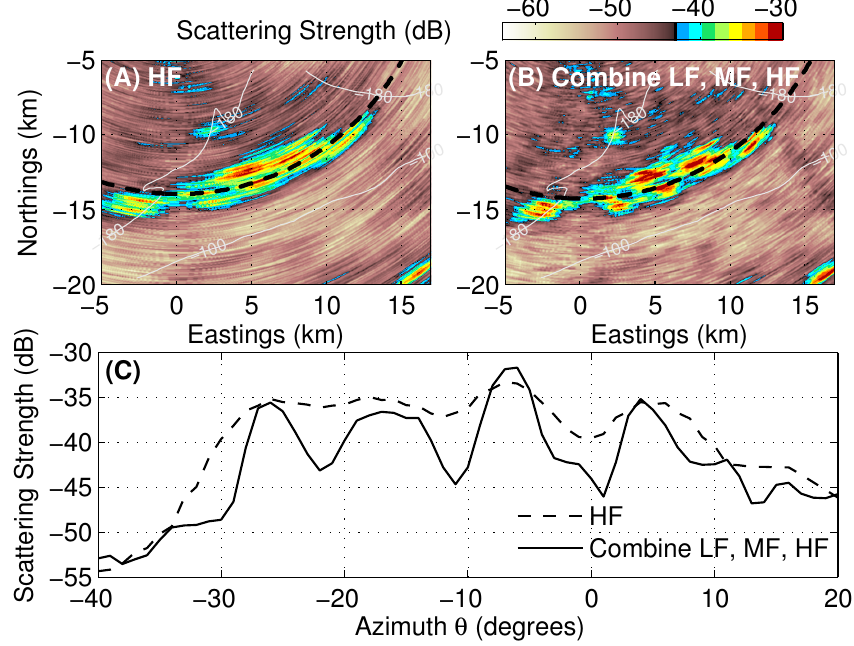
Figure 5. Comparison of instantaneous wide-area Ocean Acoustic Waveguide Remote Sensing (OAWRS) scattering strength images of a spawning Atlantic herring shoal measured on 3 October 2006 on the northern flank of Georges Bank. These images are formed from an LFM pulse transmission of 1 s duration and 50 Hz bandwidth centered at 1125 Hz (compare with Figure 1J in Ref. [2] based on an LFM pulse transmission centered at 950 Hz). The OAWRS images are generated following the approach outlined in Ref. [2,3] but is beamformed in the time domain using ( A ) the conventional uniformly-spaced HF subaperture and ( B ) the newly defined nonuniformly-spaced subarray combining LF, MF, and HF subapertures. The scattering strength values along the black dotted contours in ( A , B ) are shown in ( C ) as a function of relative bearing measured from array broadside. The fish population centers are well resolved when the acoustic data are beamformed with the nonuniformly-spaced subarray while they are merged together with the conventional HF